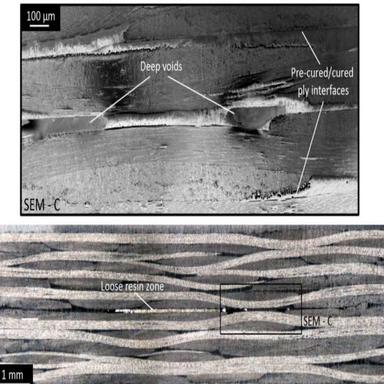
Cross-section of the 10 � 10 mm defect specimen, with feature close-up (SEM – C).